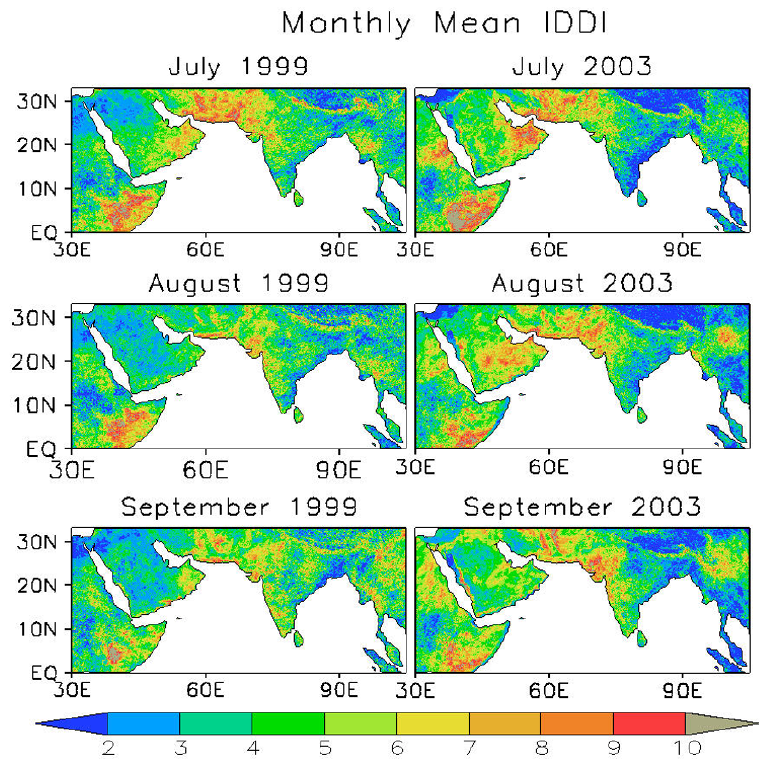
Fig. 25. Regional distribution of IDDI (K) for July, August and September (1999 and 2003).